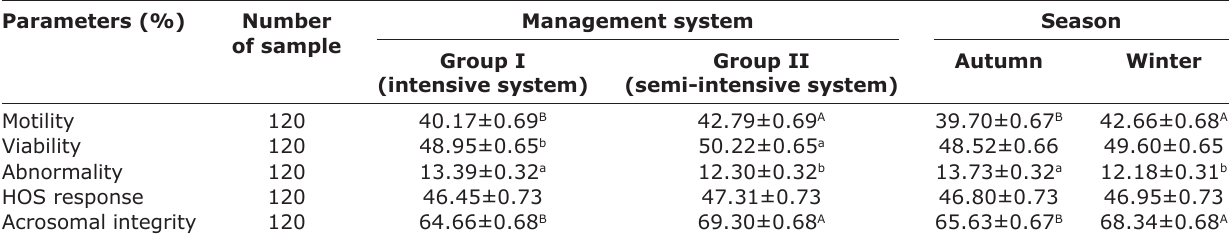
Table-2: Least square means±SE for effect of management system and season on different freezability parameters in Jakhrana bucks. Parameters